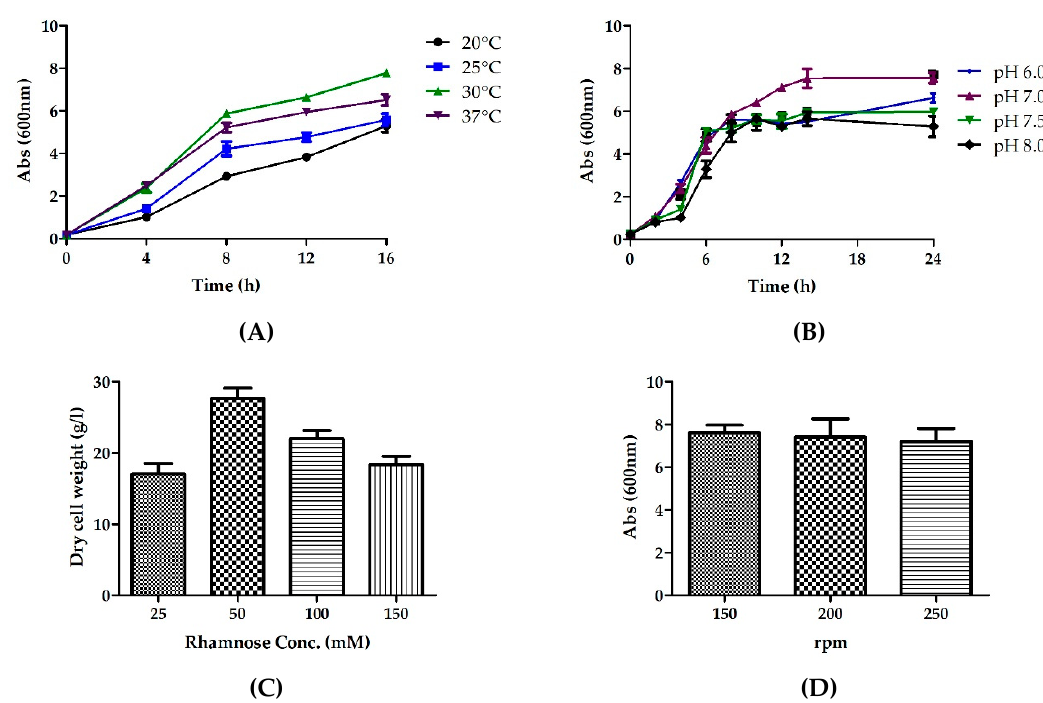
Figure 5. The optimization of various physiochemical parameters to enable higher biomass production, ( A ) temperature ( B ) pH ( C ) inducer concentration and ( D ) agitation.